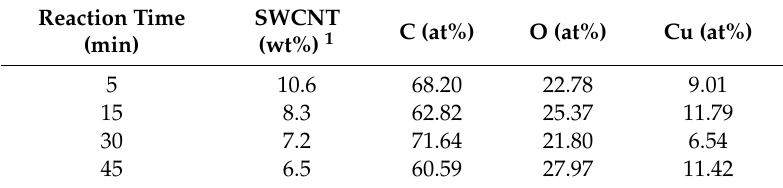
Table 4. Elemental composition of Cu-SWCNT composites prepared by electroless deposition as determined by XPS.